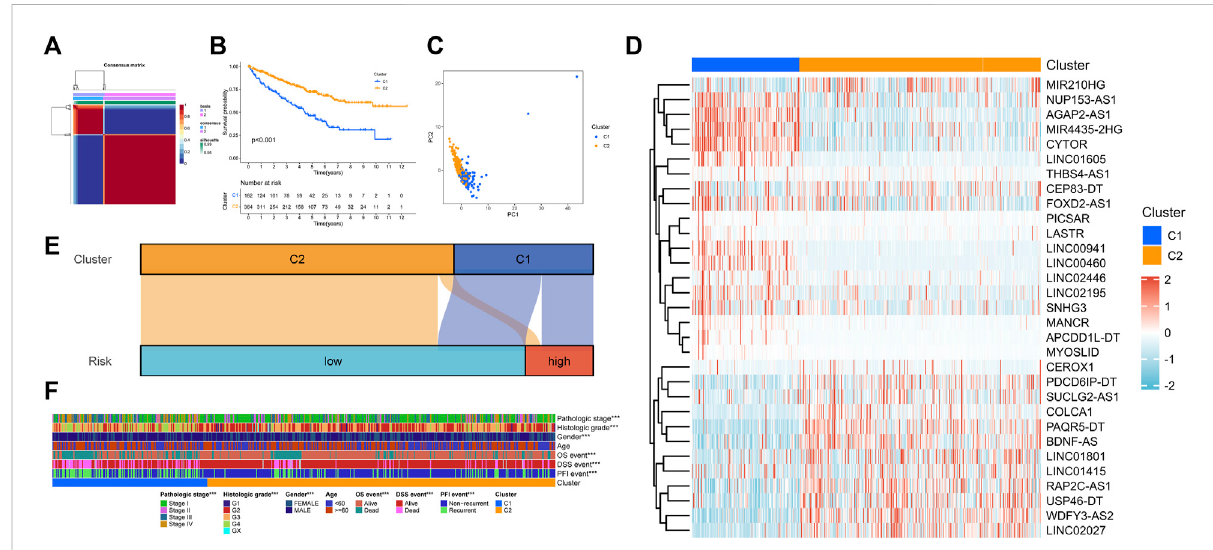
FIGURE 3 NMF clustering of cuproptosis phenotypes. (A) Consensus matrix heatmap. (B) Survival analysis of cuproptosis-related patterns. (C) PCA analysis. (D) Expression pro fi le of prognosis-related lncRNAs. (E) Sankey diagram to reveal the distribution of samples. (F) Clinical relevance of cuproptosis-related